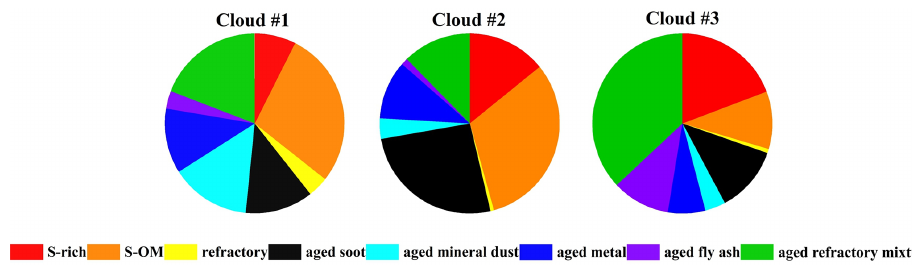
Figure 3. Number fraction of different particle types in the RES during the three cloud events measured by TEM/EDS.